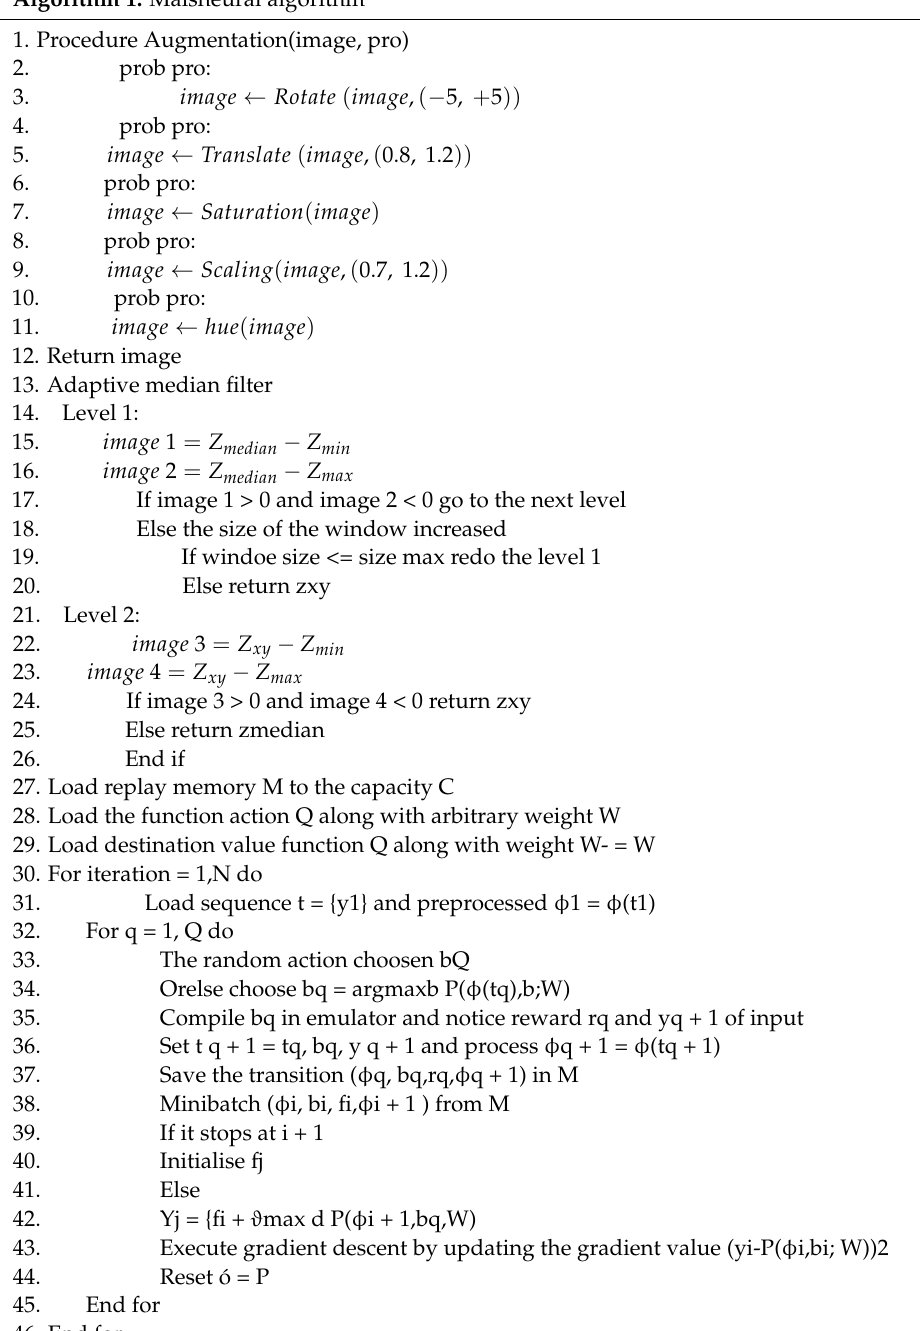
Algorithm 1: Malsneural